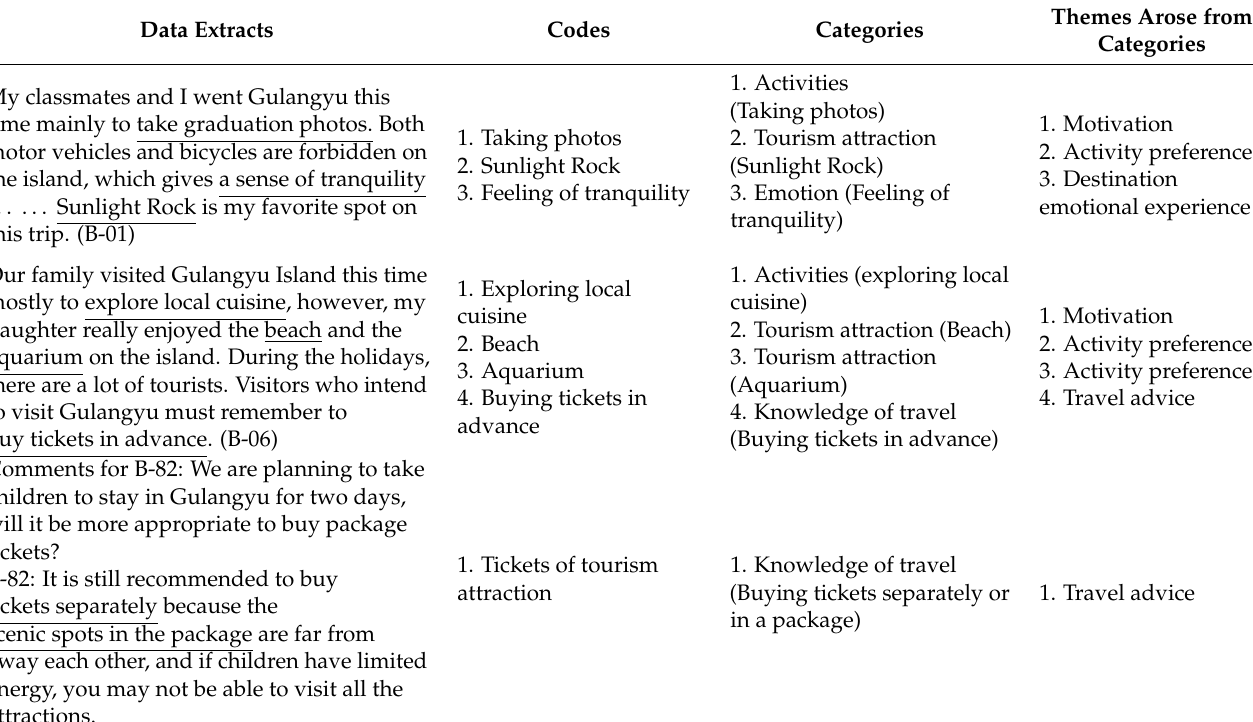
Table 1. Examples of research